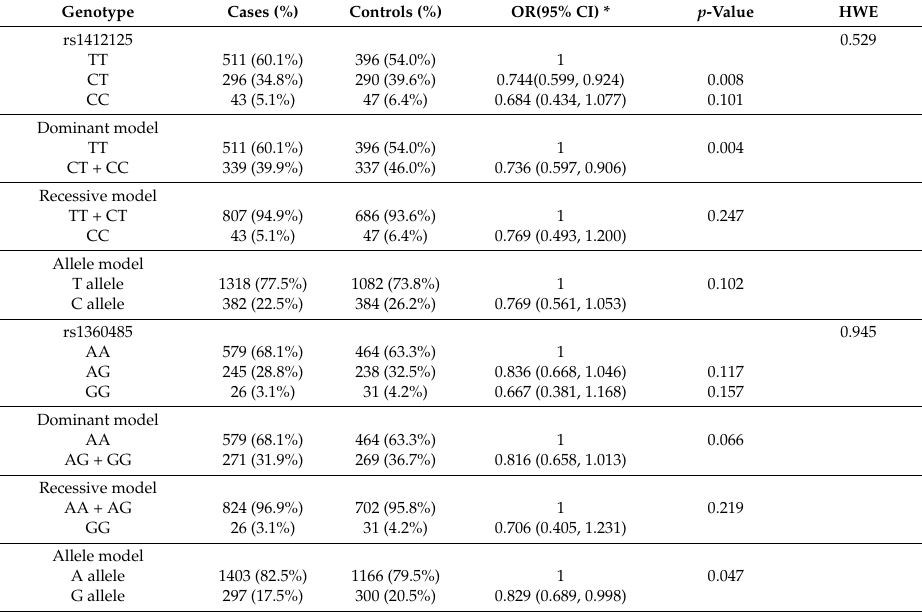
Table 2. Distribution of rs1412125 and rs1360485 and lung cancer